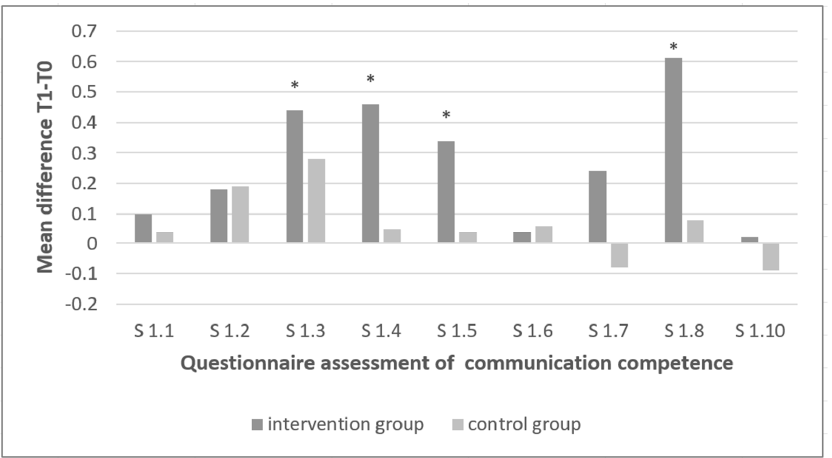
Figure 1. Questionnaire assessment of communication competence. (* significant at p < 0.05).